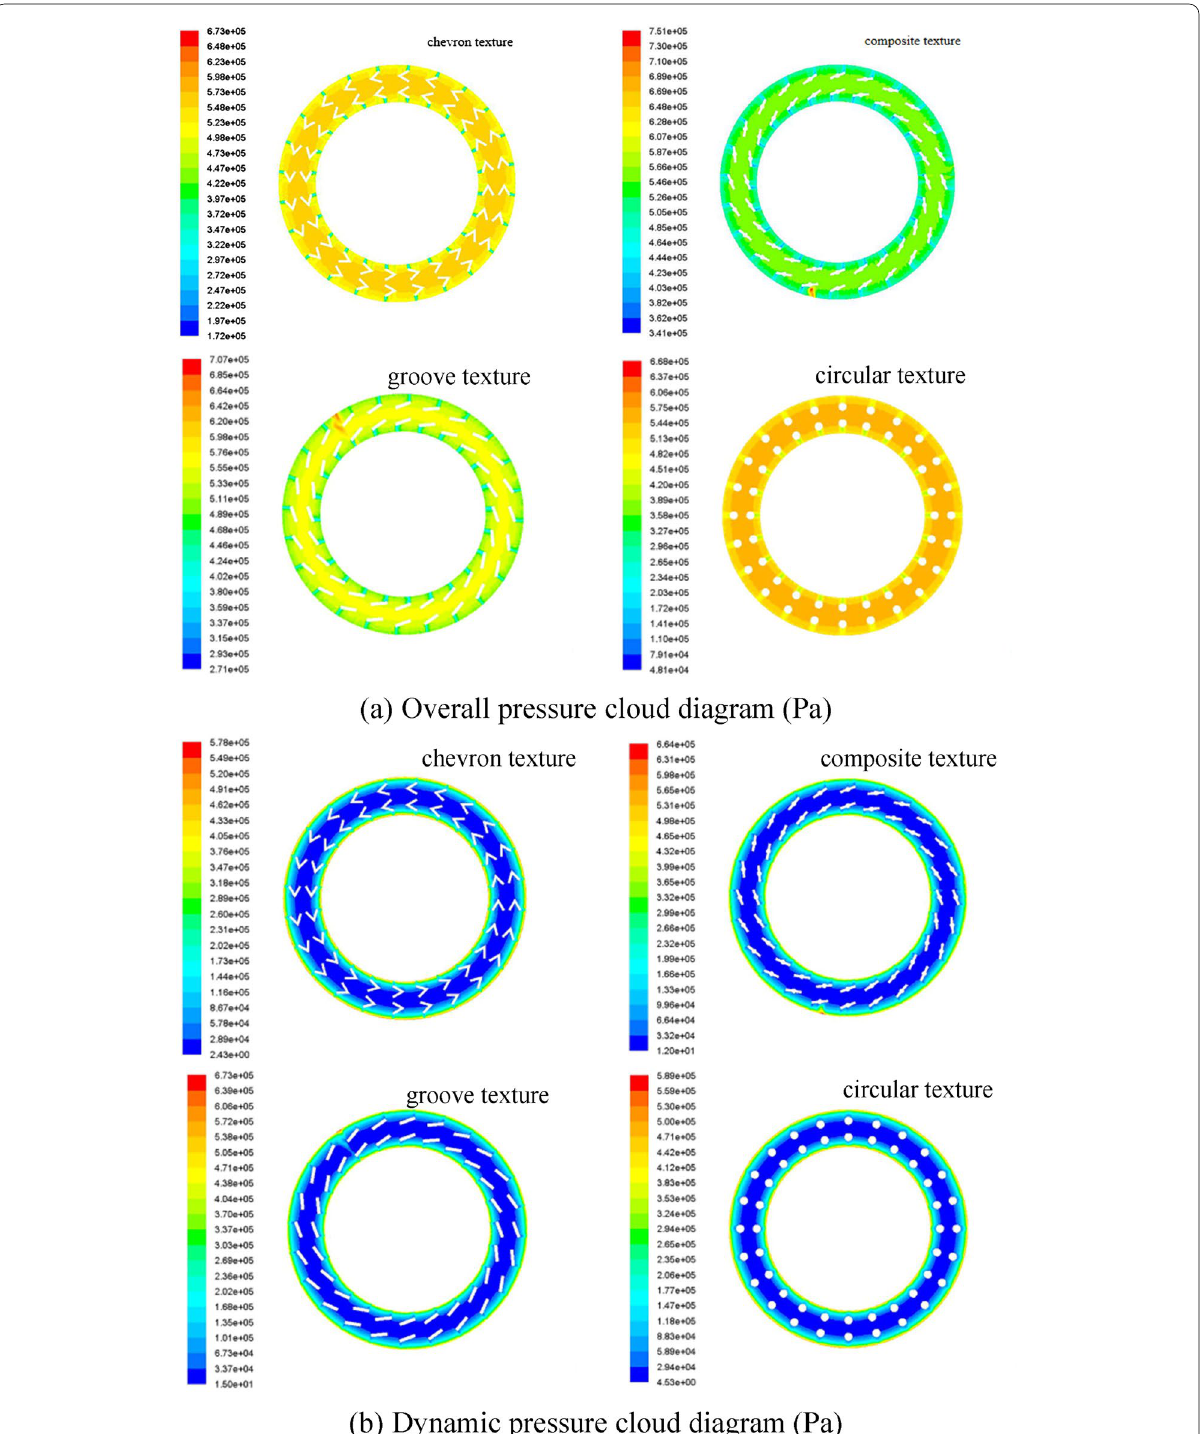
Figure 4 Overall pressure cloud diagram and dynamic pressure cloud diagram of overall